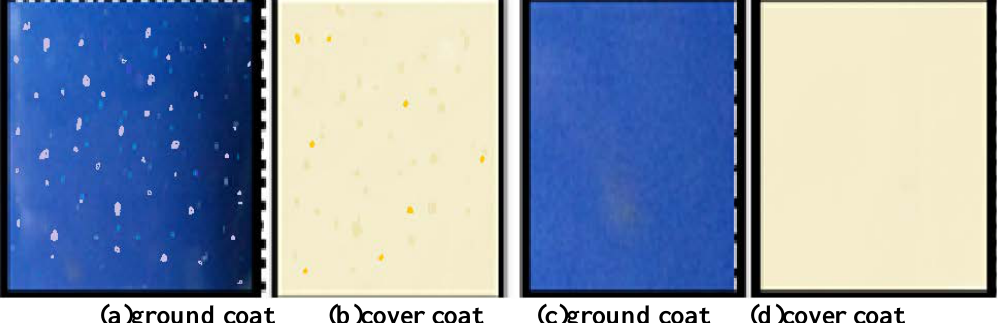
Fig.4: Cast iron enameling (X200); (a, b) without addition antimony oxide, (c, d) by addition antimony